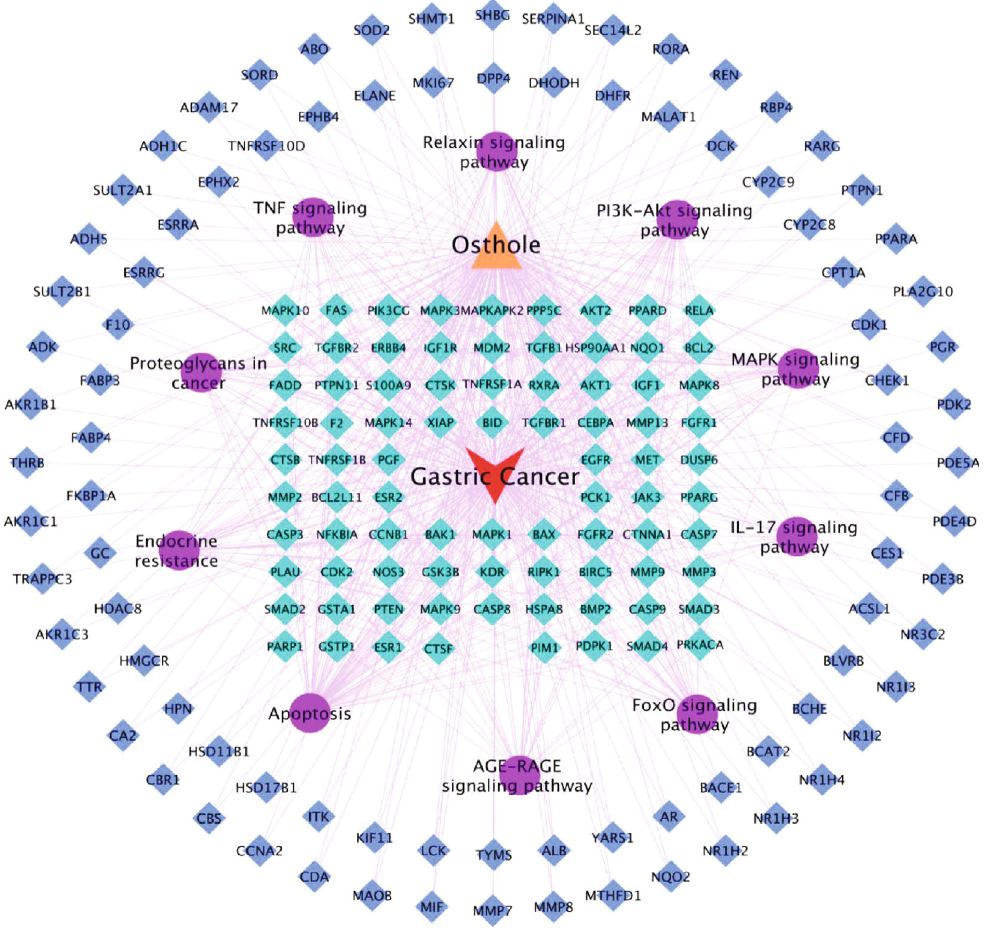
Figure 6: The Compound – Target – Pathway – Disease network (the green nodes are pathway disease cotargets; the blue nodes are targets that do not involve pathways. The red, purple, and orange nodes represent diseases, pathways, and compounds; edges represent their interactions). Table 1: Binding energy values of core compounds of osthole and core